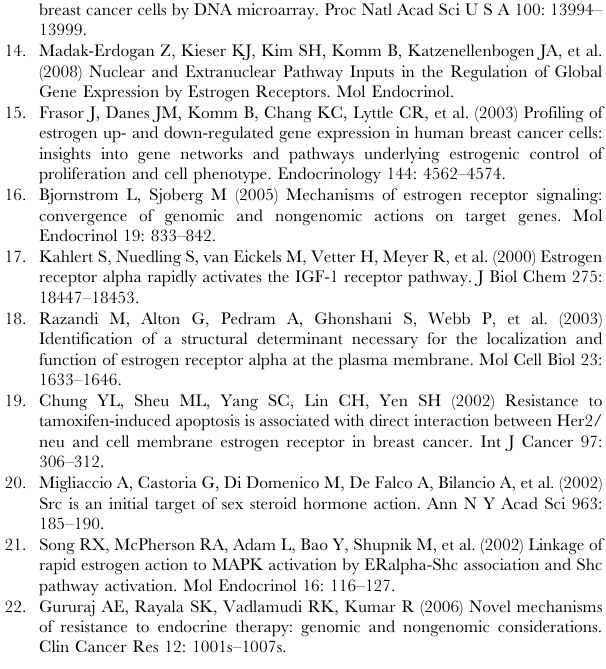
Table S1 The TRC collection of shRNA lentiviral clones targeting human